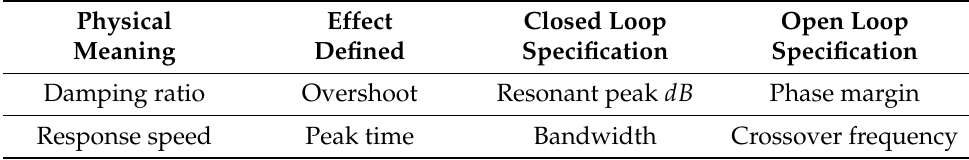
Table 2. Equivalence between frequency specifications and time